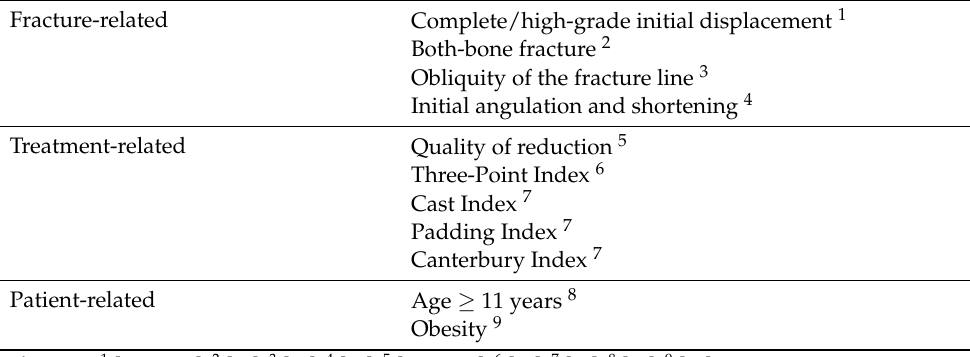
Table 1. Risk factors for secondary displacement of nonoperatively treated distal forearm fractures in